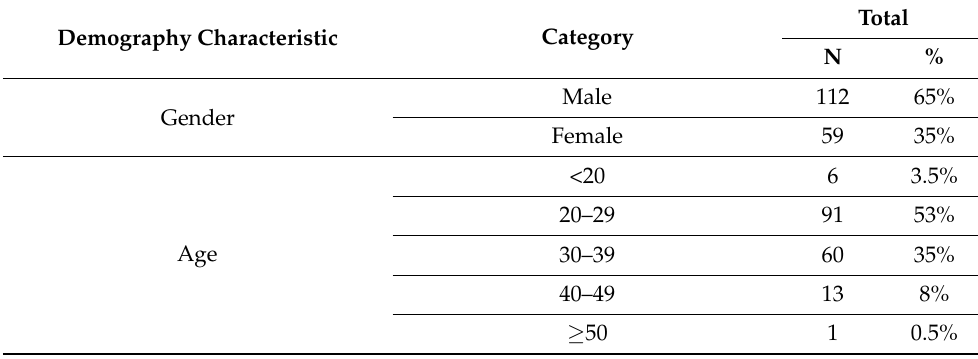
Table 1. Respondent